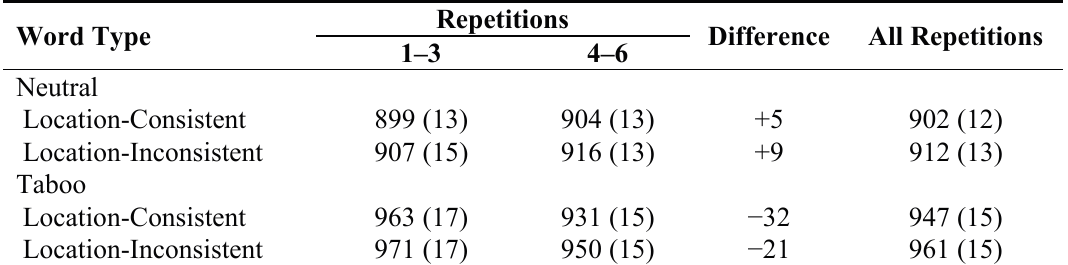
Table 3. Mean color-naming RTs for location-consistent vs. location-inconsistent words by word type and repetition in Experiment 2.